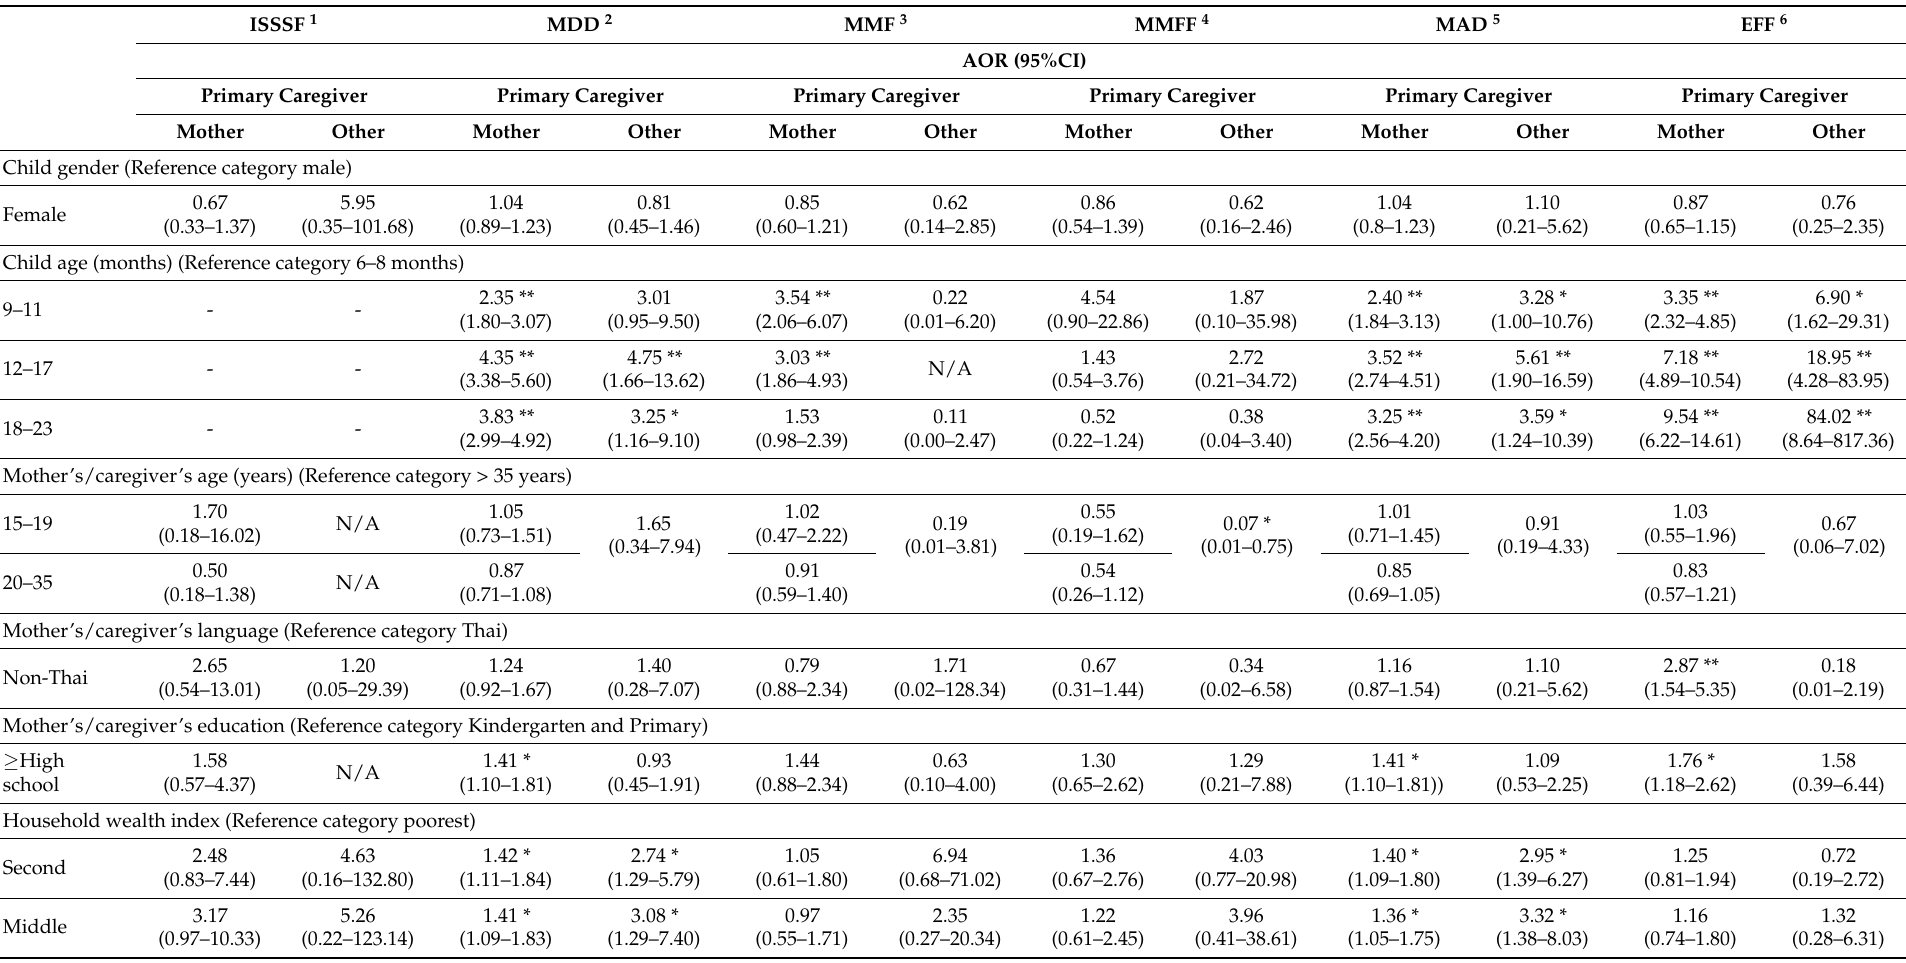
Table 4. Factors associated with complementary feeding indicators, ISSF, MDD, MMF, MMFF, MAD, EFF, the multivariate logistic regression